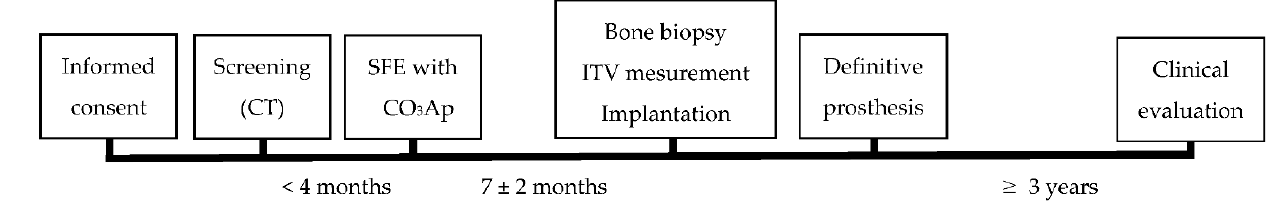
Figure 2. A time-sequence chart of the procedures. CT: computed tomography; SFE: sinus floor elevation; CO 3 Ap: carbonate apatite; ITV: insertion torque